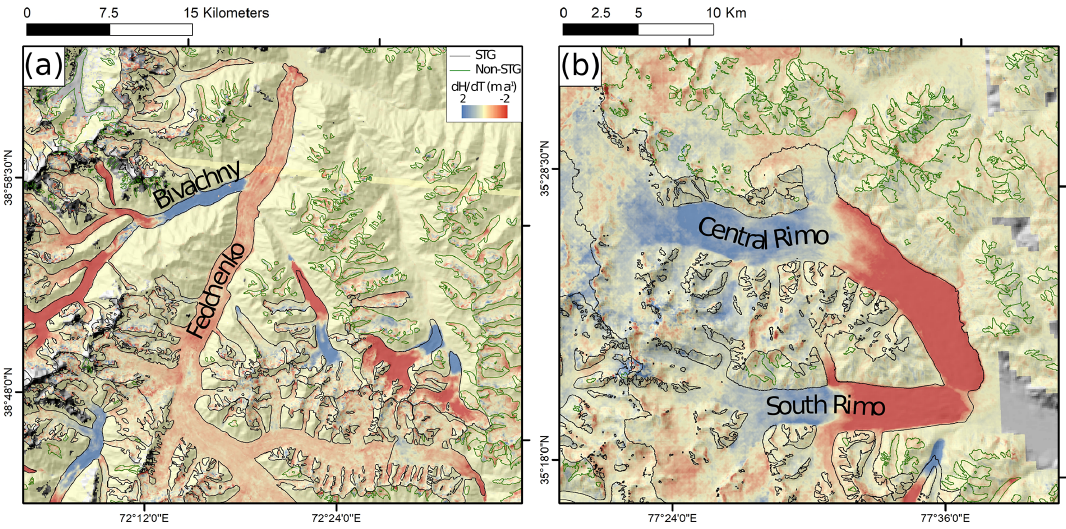
Figure 1. Examples of surface elevation change data used to identify surge-type glaciers. (a) Ice mass transfer associated with the surges of Bivachny Glacier, and other local glaciers, over the period 2010–2019 (data from Hugonnet et al., 2021). (b) Ice mass build-up in the reservoir zones of Central and South Rimo glaciers over the period 2000–2018 (data from Shean et al., 2020). Glacier outlines are from the Randolph Glacier Inventory V6.0 (RGI V6.0) (RGI Consortium,